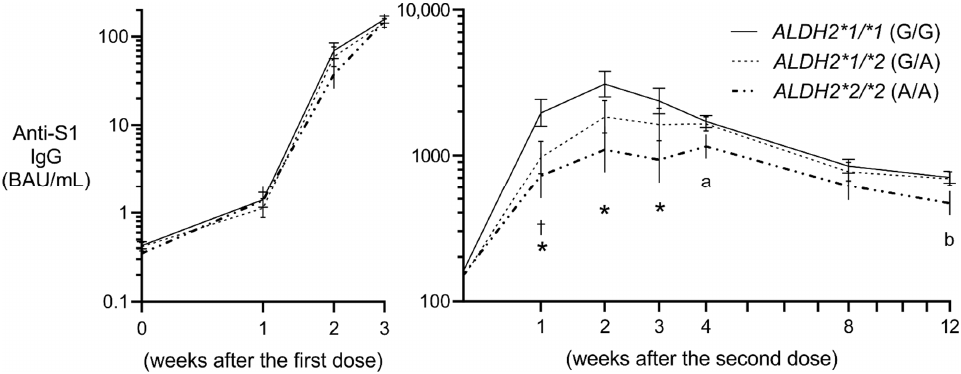
Figure 1. Estimated anti-S1 IgG antibody levels by ALDH2 rs671 genotype. Least squares geometric means and standard errors were computed by a mixed model, which includes all the covariates